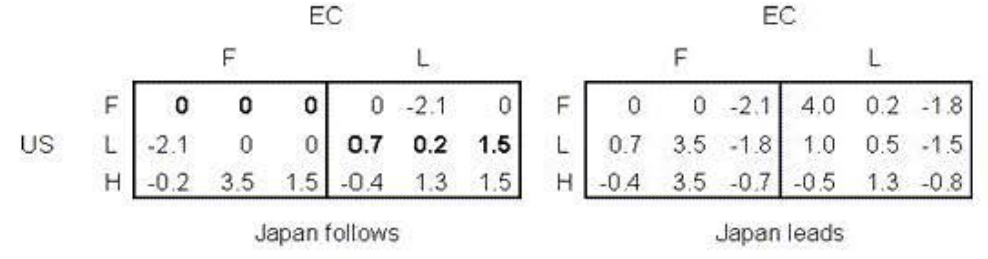
Table 4. 2 The game in 1975 with